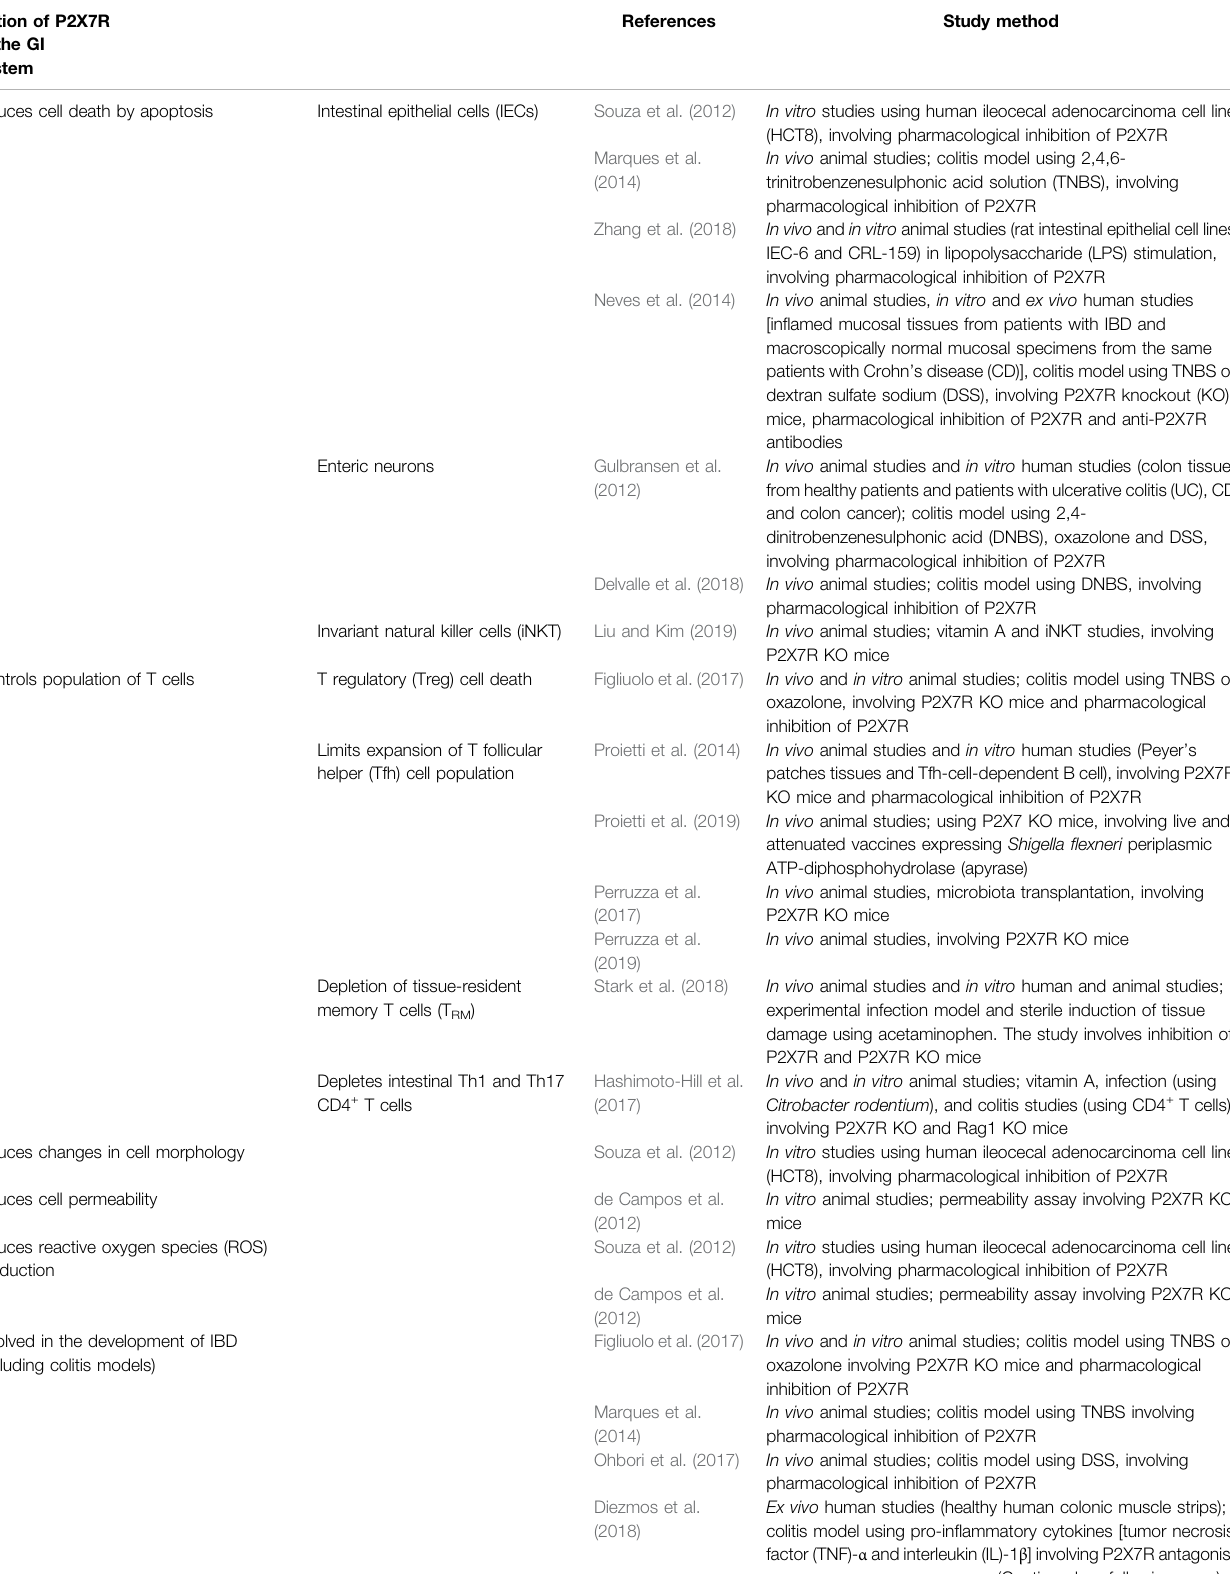
TABLE 1 | Table summarizing action of P2X7R in the GI